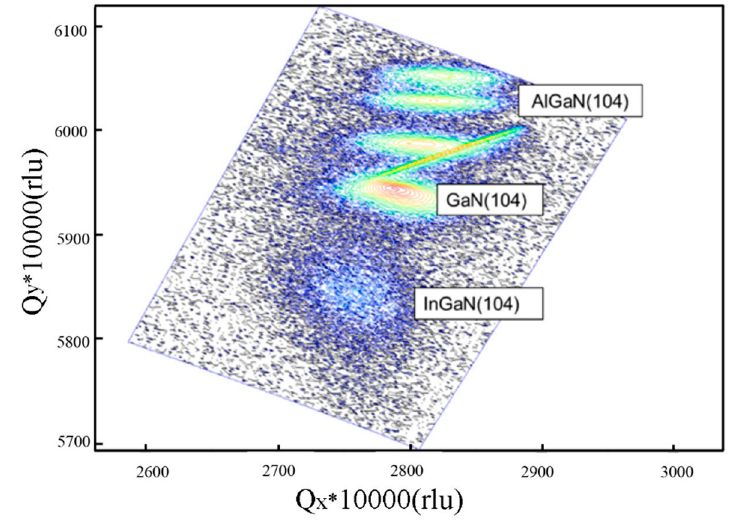
Figure 4. ( a ) XRD (002)-plane 2theta-omega scan for the InGaN/GaN heterostructure on AlGaN/GaN-on-Si HEMT at the temperature of 780 °C. ( b ) The corresponding XRD rocking curve of (002)-plane for the InGaN epitaxial layer.